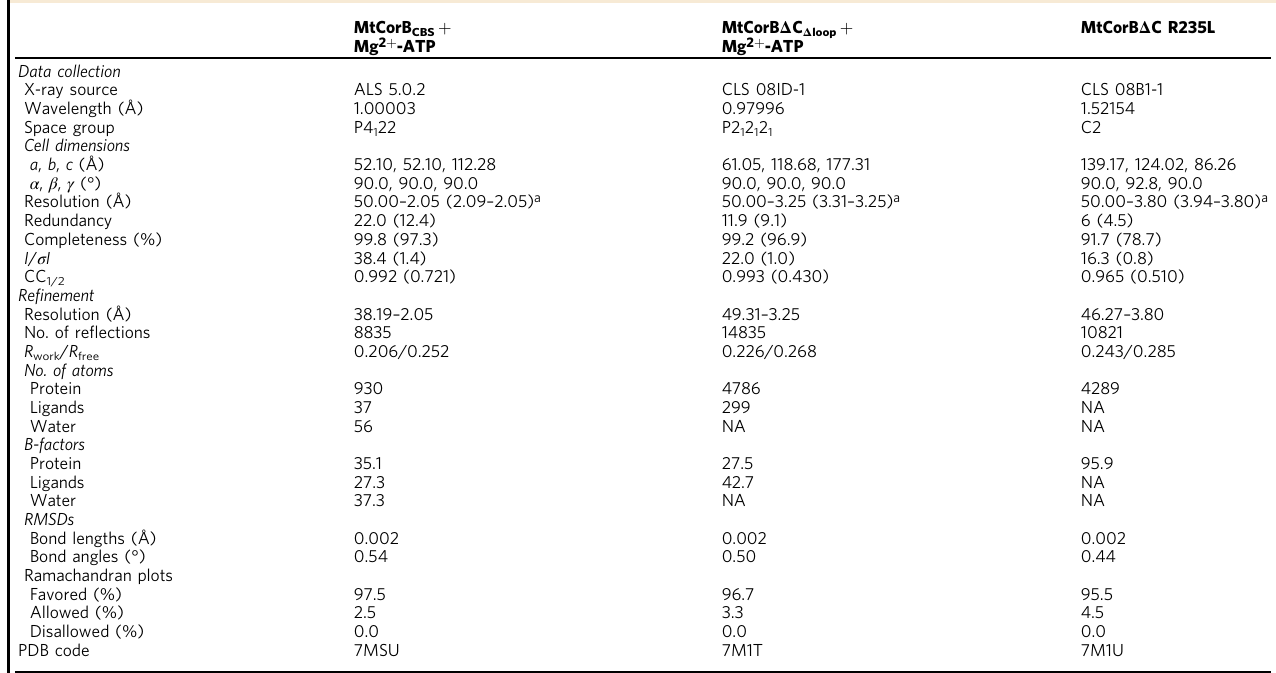
Table 1 Statistics of data collection and re fi